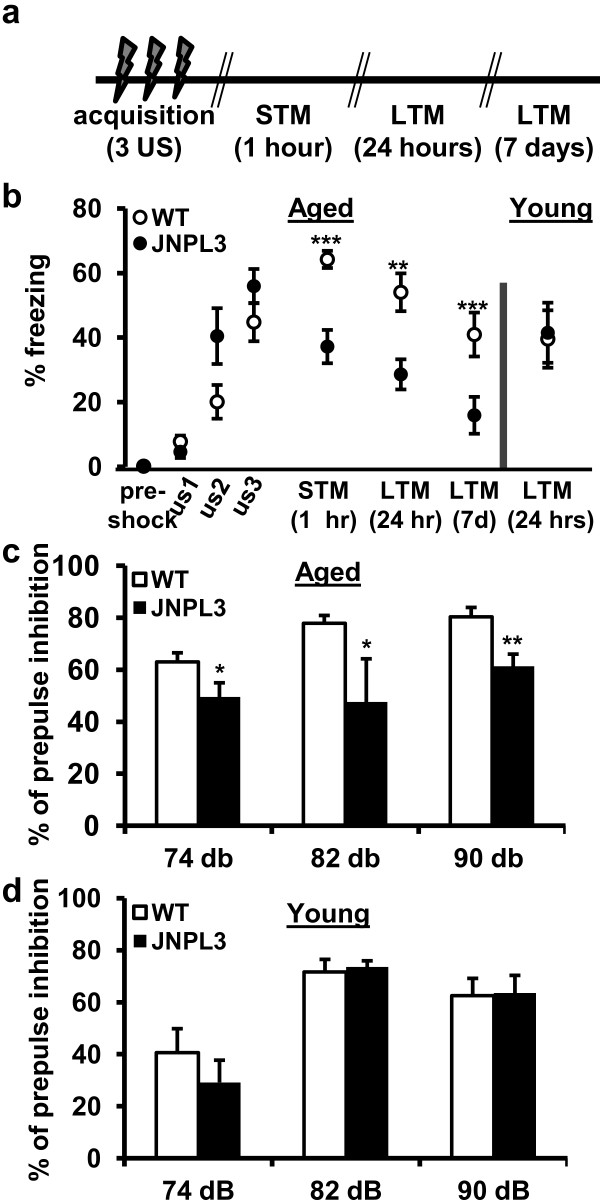
Over-expression of mutant tau impairs memory and sensori-motor gating in an age dependent fashion (a) Schedule of contextual fear conditioning testing (US=unconditioned stimulus; memory tested at 1h, 24h and 7d delay). (b) Aged Tg mice (age 12–13 months) showed impaired short-term (STM, 1 h) (WT=11 mice, Tg=12 mice, t21=4.522, ***P=0.0002) and long-term memory (LTM, 24h: t21=3.424, **P=0.0026; 7d: t21=4.283, ***P=0.0003) when compared to WT mice. Young Tg mice (5–6 months) showed normal memory when compared to age-matched WT controls (right panel) (WT=9 mice, Tg=10 mice, t17=0.2793, P=0.7834). (c) Sensori-motor gating was impaired in aged Tg mice (WT=17 mice, Tg=8 mice; 72dB: t23=0.2.130, *P=0.0441; 82dB: t23=2.532, *P=0.0186, 90dB: t23=3.040, **P=0.0058). (d) Young Tg mice had normal sensorigating when compared to young WT controls (WT=11 mice, Tg=11 mice; 72dB: t20=0.9115, P=0.3729; 82dB: t20=0.3533, P=0.7276, 90dB: t20=0.1095, P=0.9139). Data are presented as mean ± SEM.; n.s. not significant.